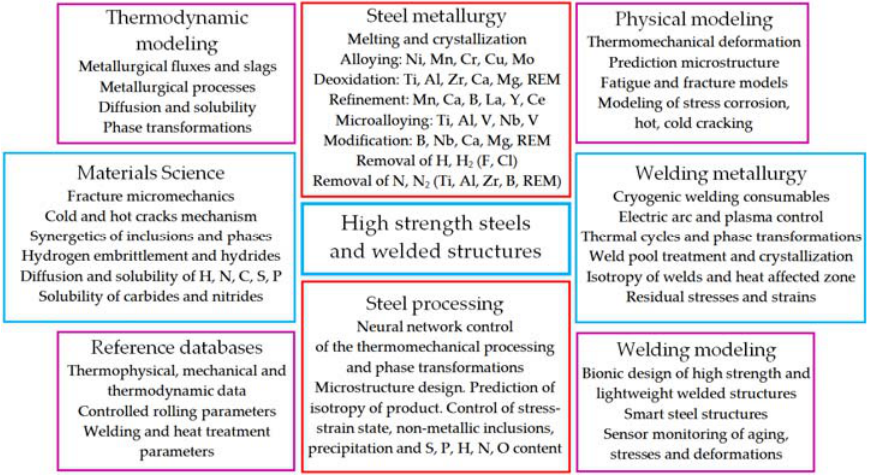
Figure 4. System of advanced trends and methods in the metallurgy and weldability of high-strength steels for welded structures for low temperature and cryogenic service.